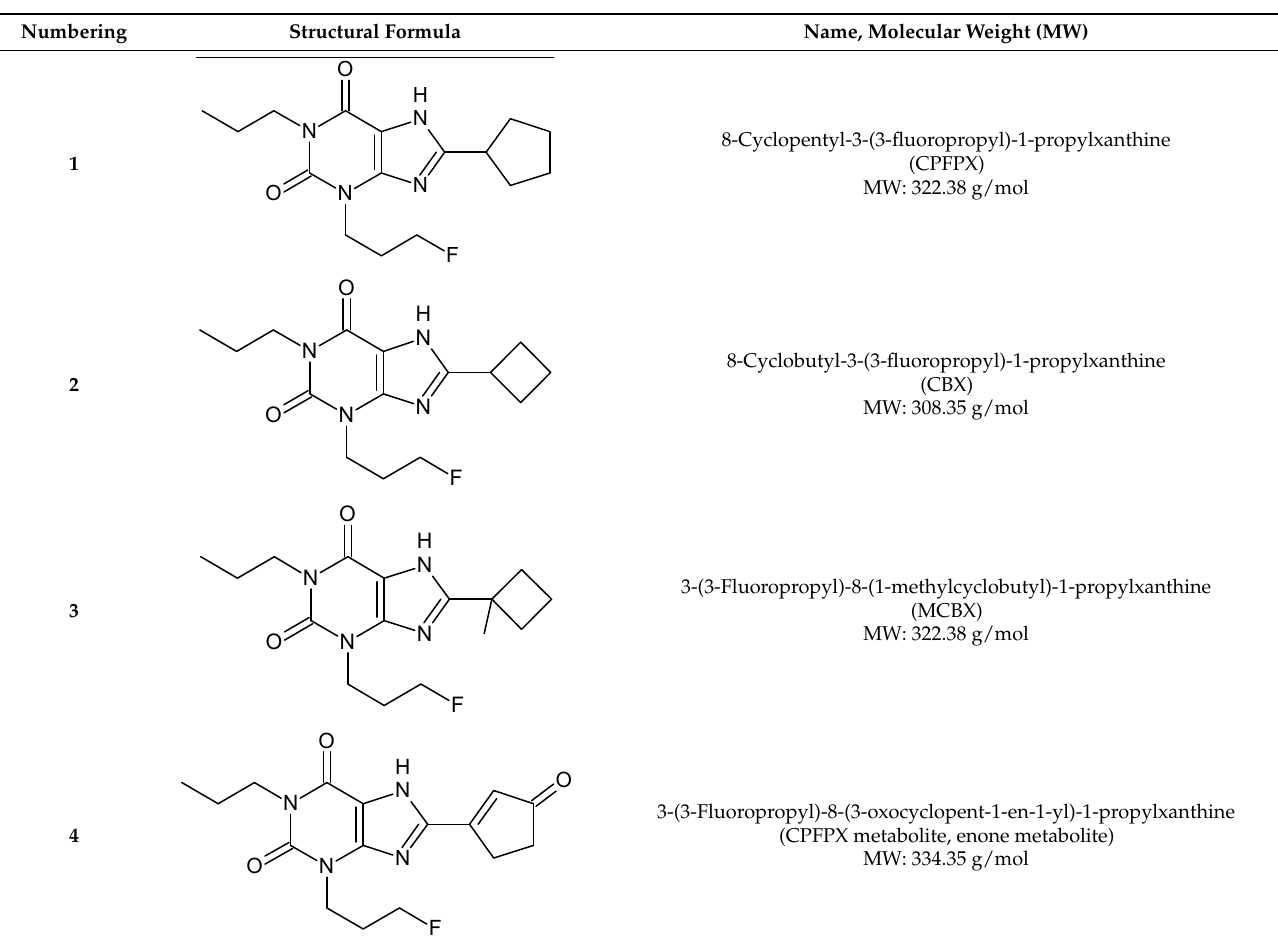
Table 1. Structural formulae of the ligands and metabolites used in this study. All compounds were synthesized and characterized in-house.